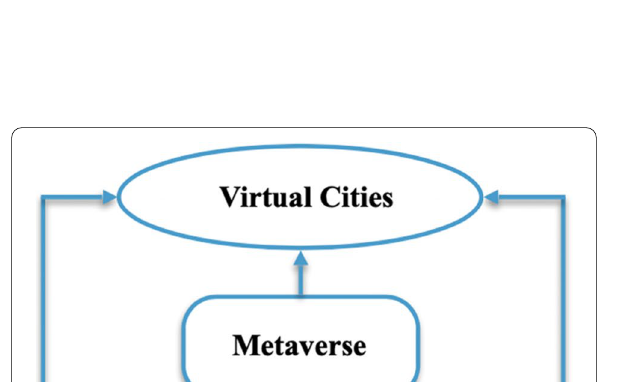
Source: Adapted from Bibri and Krogstie